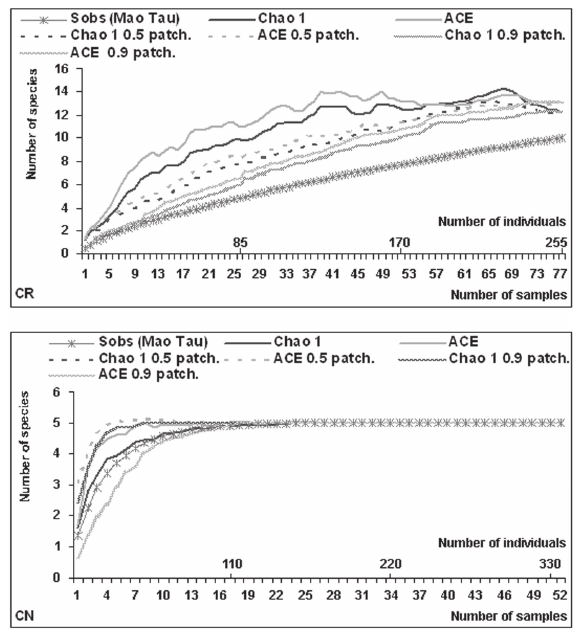
Figure 3 - Rarefaction curves of observed copepod species rich- ness and estimates for: CR basin (10 species, 78 samples); CN basin (5 species, 52 samples) based on the cumulated data from all five caves.